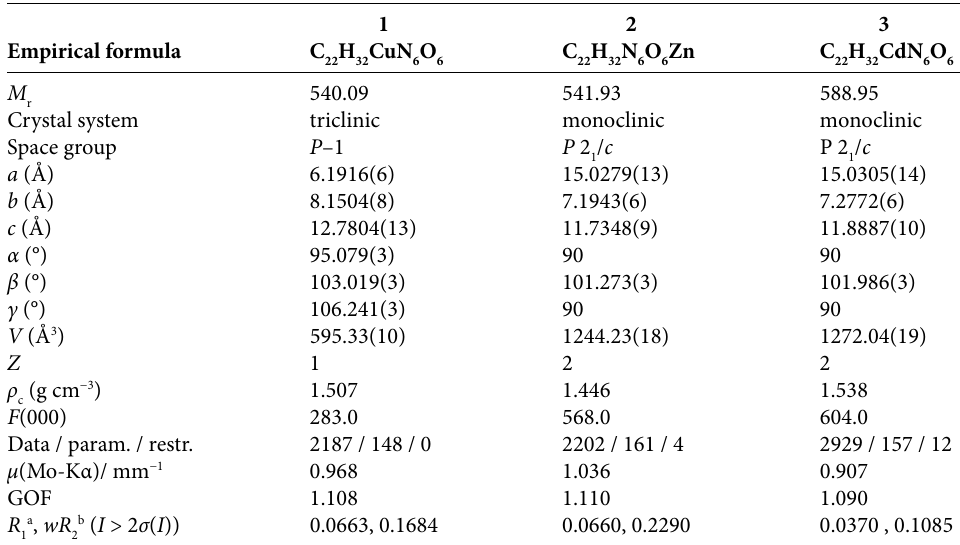
Table 1. Crystallographic data for complex 1 –